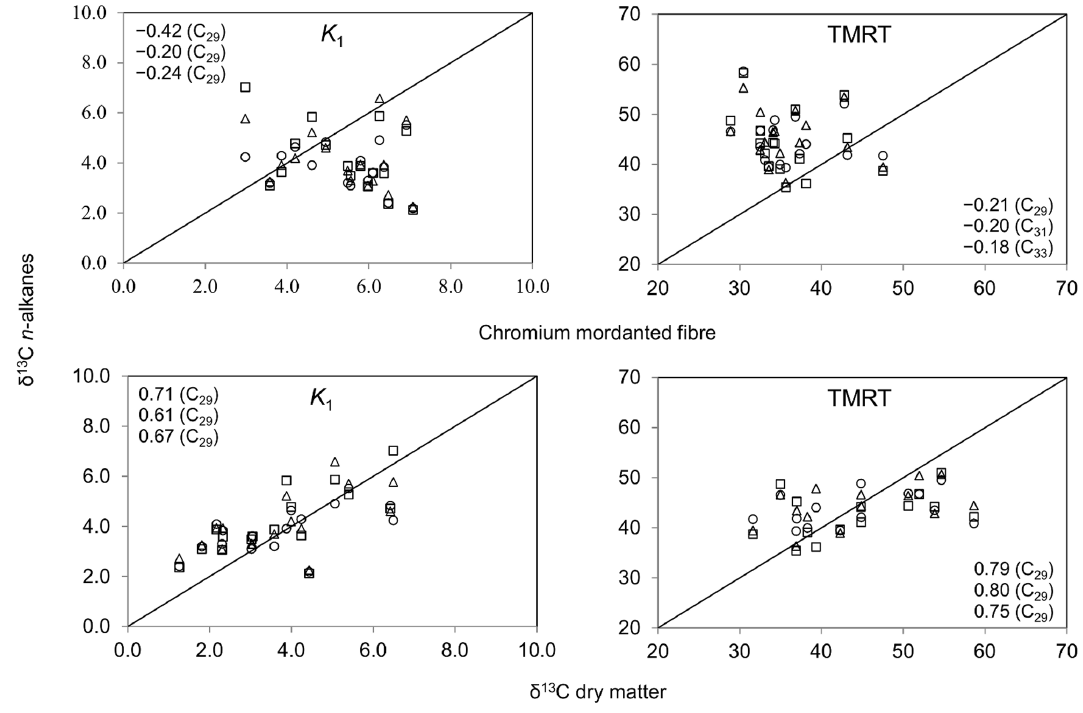
Figure 3. Relationship between d 13 C labeled n -alkanes and chromium mordanted fiber or d 13 C labeled dry matter. n -Alkanes: C 29 ( % ), C 31 ( # ), C 33 ( D ). Pearson correlation coefficients shown in plots. K 1 =fractional rumen passage rate (%/h); TMRT=total mean retention time (h). Mean K 1 is (mean 6 SEM) 3.38 6 0.315%/h for d 13 C labeled dry matter and 5.25 6 0.490%/h for chromium mordanted fiber; mean TMRT is 47.1 6 2.52 h for d 13 C labeled dry matter and 35.7 6 1.91 h for chromium mordanted fiber.